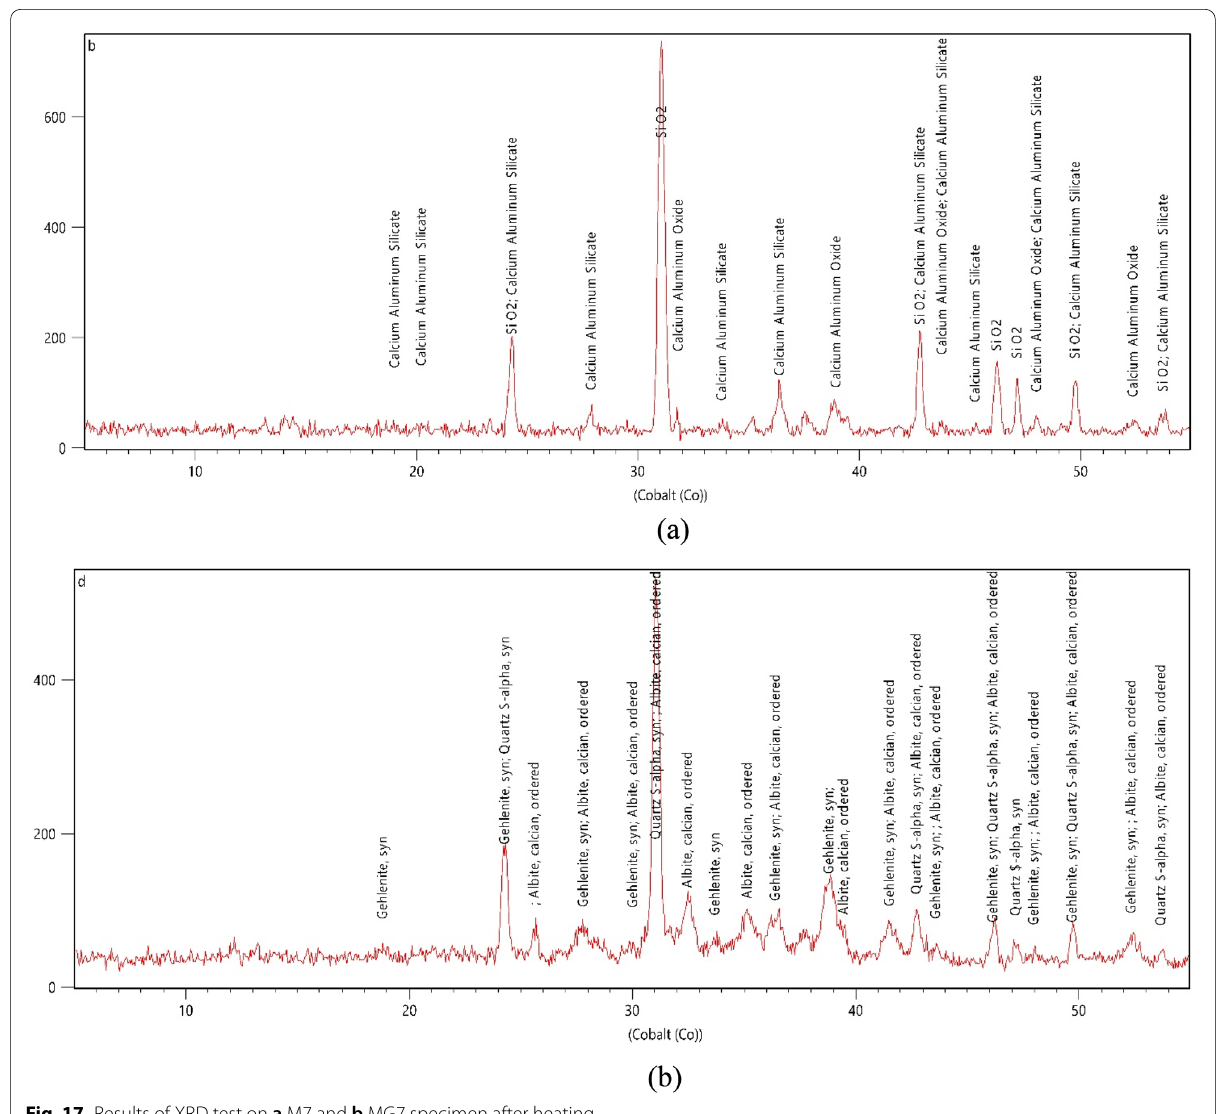
Fig. 17 Results of XRD test on a M7 and b MG7 specimen after